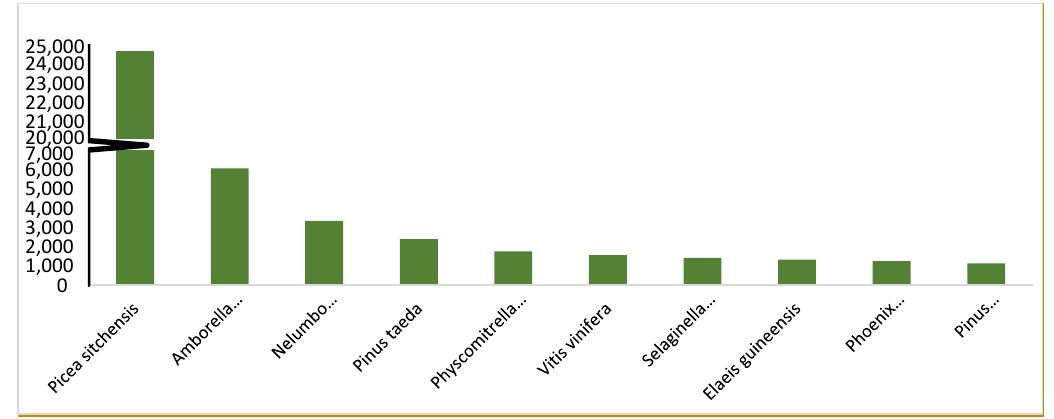
Figure 4. Distribution of the top ten species with more BLAST hits retrieved from the NCBI NR-plants database. The bar plot shows the number of Pinus yunnanensis genes whose best-matching protein hits were from the indicated species.